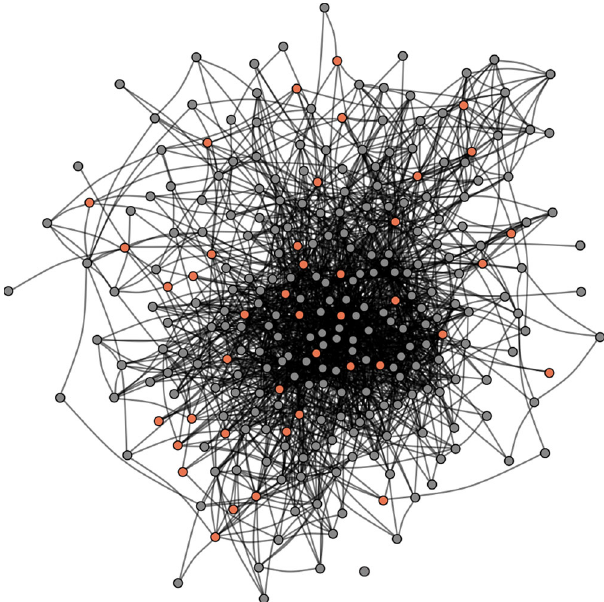
Fig. 1 Social network. The social network of an entire cohort of fi rst-year graduate students was reconstructed based on a survey completed by all students in the cohort ( N = 279; 100% response rate). Nodes indicate students; lines indicate mutually reported social ties between them. A subset of students (orange circles; N = 42) participated in the fMRI